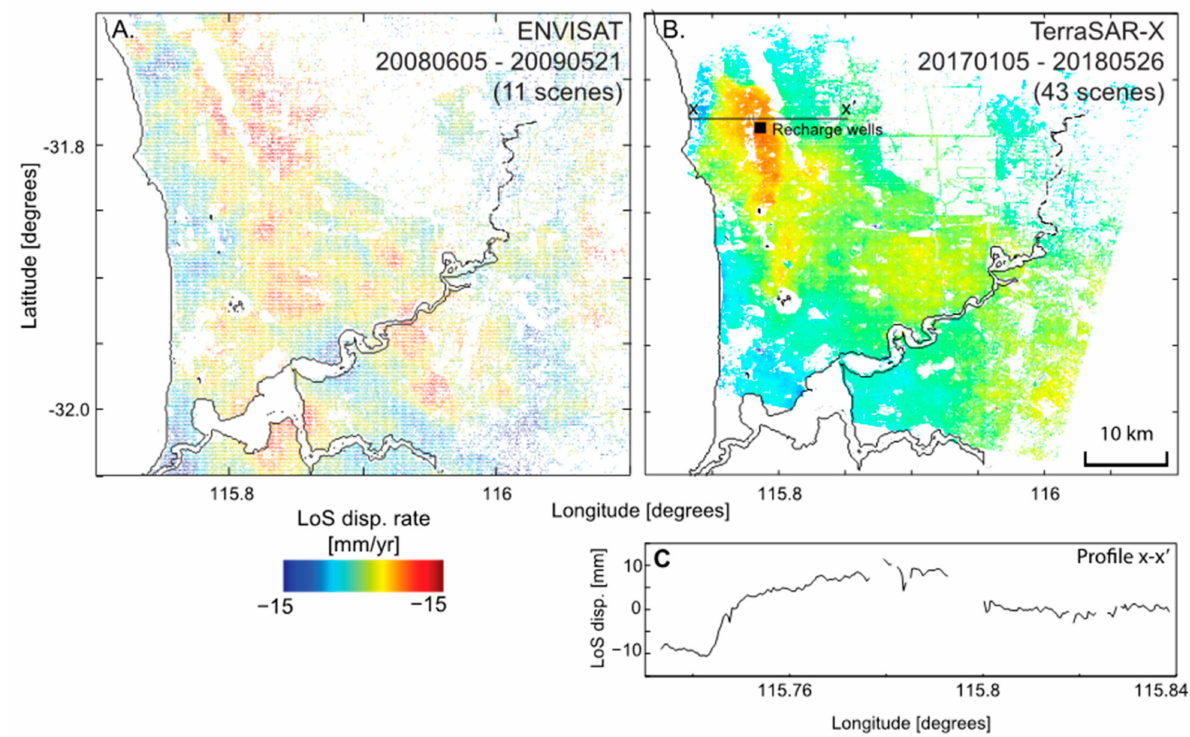
Figure 4. Monitoring ground deformation related to groundwater storage change in Perth, Western Australia, using InSAR analysis of ENVISAT ASAR and TerraSAR-X. ( A ) Map of average LoS displacement rate over an 11-month period using a historical SAR dataset (ENVISAT ASAR). Signals are not consistent with groundwater features or other conceivable causes of ground displacements and are instead dominated by atmospheric phase contributions. ( B ) Map of average LoS displacement rates measured during the first stage of Managed Aquifer Recharge (MAR) activities. Positive LoS displacements are centred around the location of MAR recharge wells (black square). ( C ) Transect that was taken across the x-x’ east-west profile in B, showing relative cumulative LoS displacements on the order of 10 mm over this